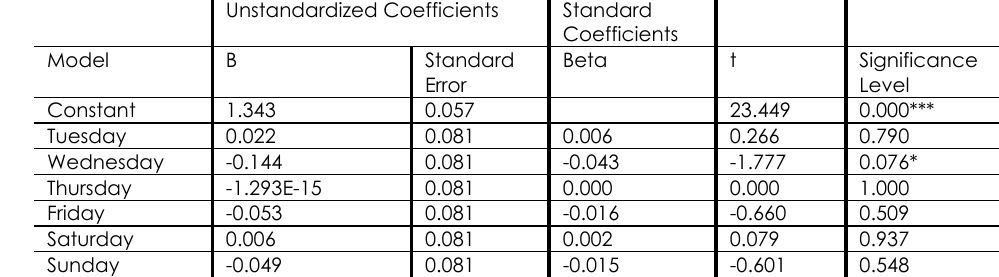
Table 5. Table of coefficients in the model established to determine whether there is a day effect on accidents. Unstandardized Coefficients